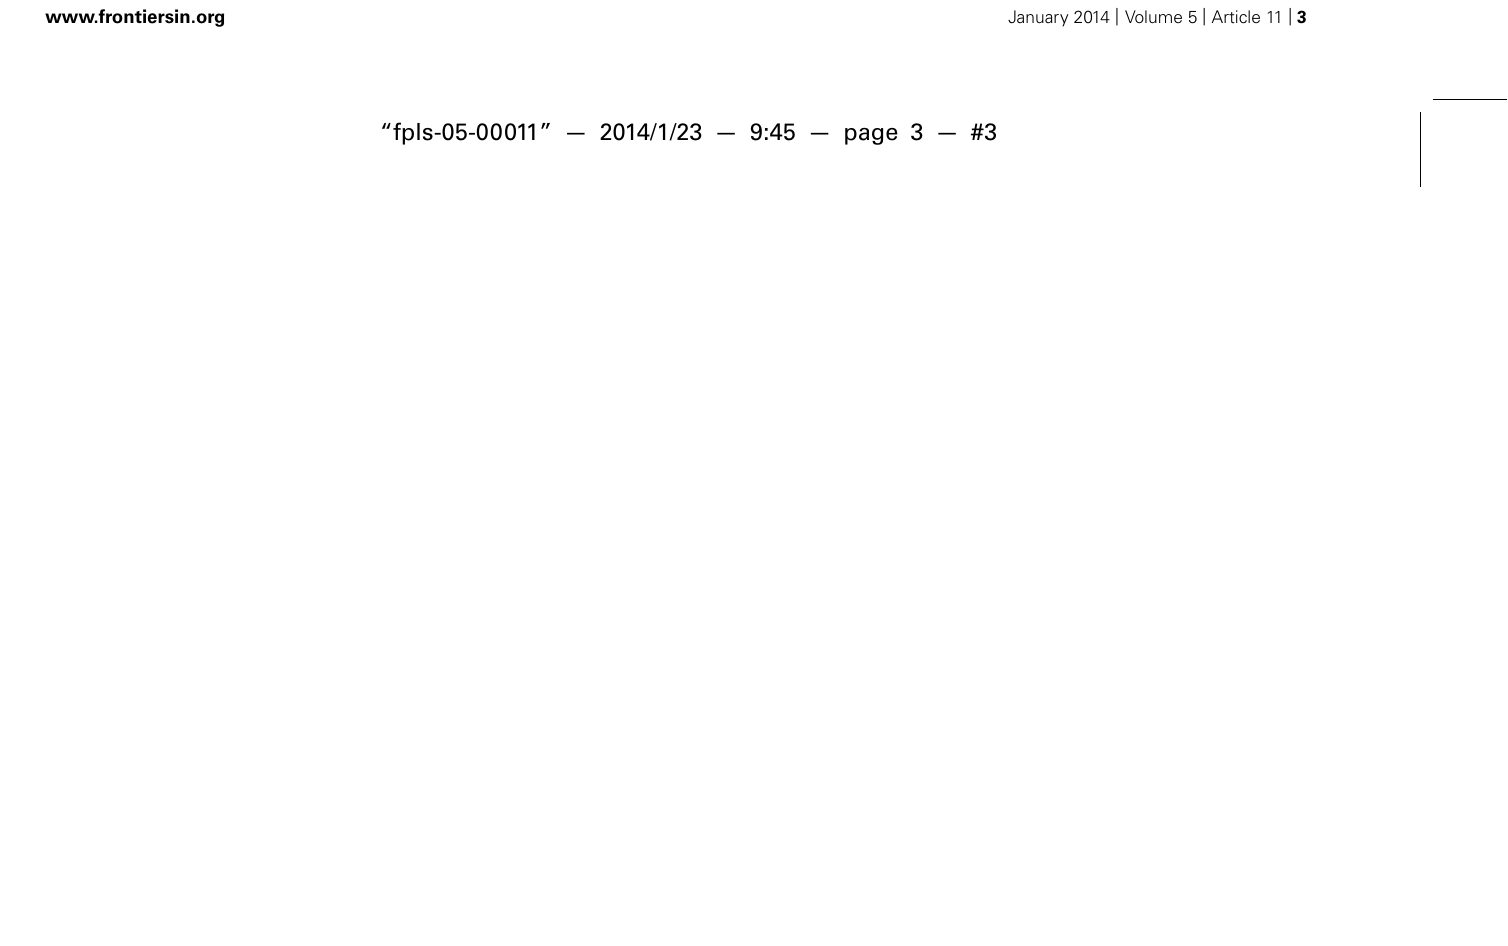
FIGURE 2 | Sink/source transition at the cellular level. Active photosynthetic cells perform carbon fixation, energy production and anabolism and require micronutrients for these functions. Senescence modifies these sink cells into a source cells undergoing catabolism. Intense catabolism activities and nutrient recycling occurs in chloroplasts, cytosol, and vacuole allowing nutrient remobilization. Chloroplasts, which concentrate a large part of metals, are first affected (Zavaleta-Mancera etal., 1999). Pigment degradation directly takes place in chloroplasts (Hörtensteiner etal., 1995; Park etal., 2007). However, stromal proteins are degradated into the central vacuole through rubisco containing body (RCB: autophagosome) or into senescence associated vacuoles (SAV) through an